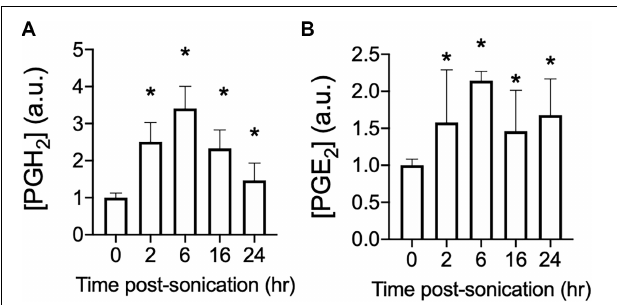
FIGURE 1 | Time course of PGH 2 and PGE 2 following pFUS to skeletal muscle. Mouse hamstrings ( n = 6 per time point) were treated with pFUS at 1.15 MHz and 8 MPa. Hamstrings were harvested at various time points and relative changes in PGH 2 (A) and PGE 2 (B) are shown. Asterisks represent statistically significant differences ( p < 0.05 by ANOVA) compared to sham pFUS treatment (0 h time